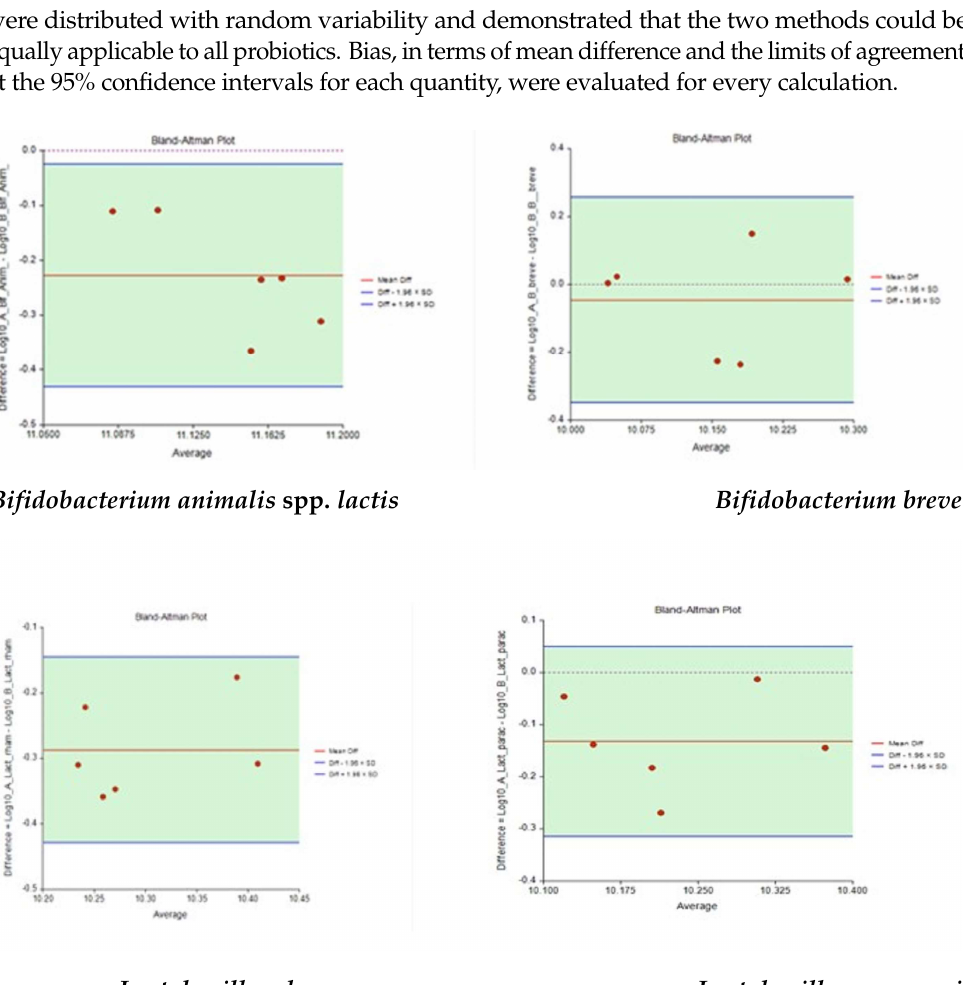
Figure 5. Bland–Altman plots for data from Table 7, with the representation of the limits of agreement (blue line) from − 1.96 × SD to 1.96 × SD. SD: Standard Deviation; Diff: difference.